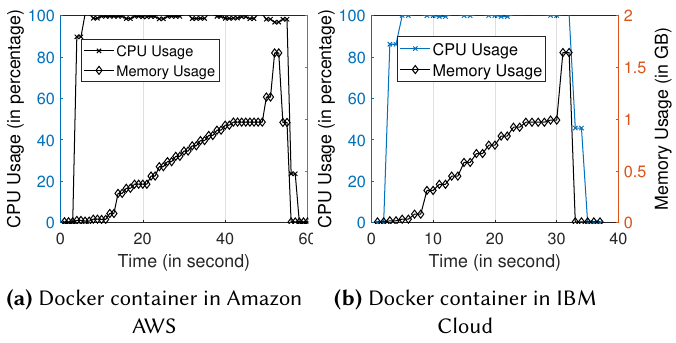
Figure 13. The CPU and memory usage for Docker containers in AWS and IBM